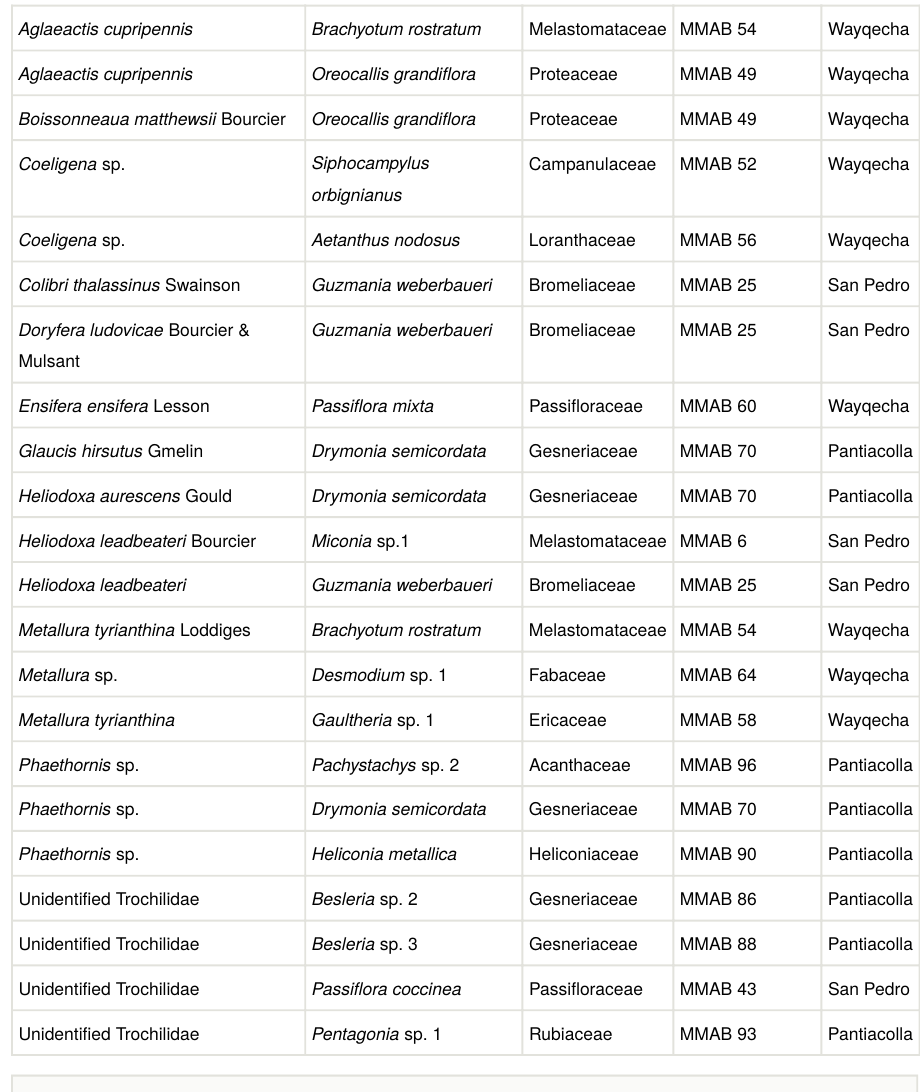
Table 3. Basic bill morphometrics from birds mist-netted along the Manú